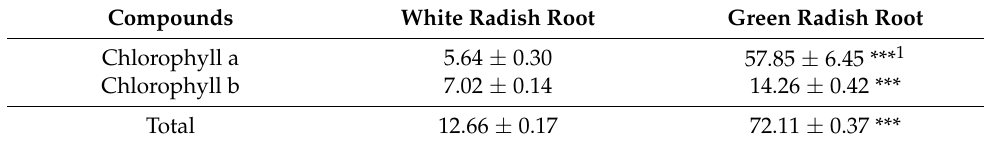
Table 3. Chlorophyll content in white and green radish cultivars ( µ g g − 1 ). Compounds White Radish Root Green Radish